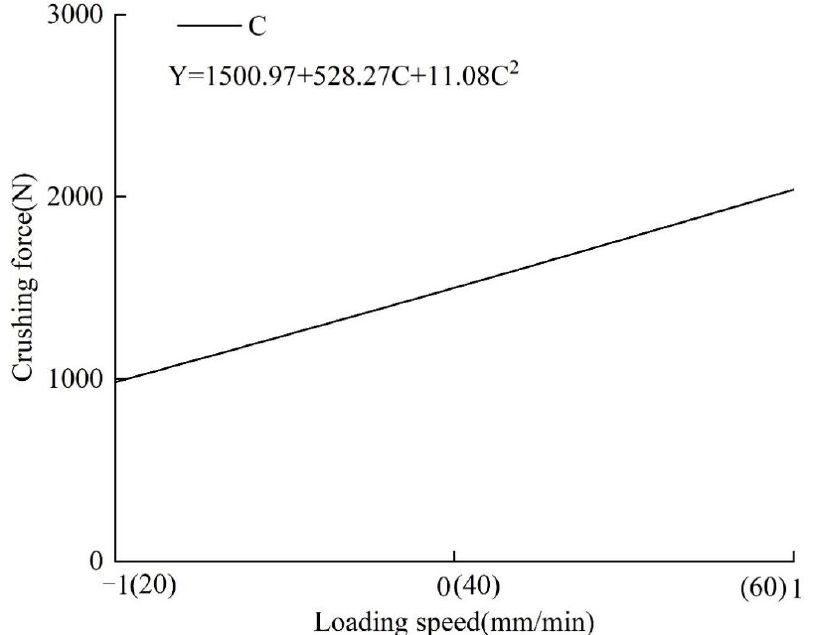
Figure 4. Influence of single factors on the shear force on corn bale samples. ( A ) Influence of water content on crushing force of corn bale samples. ( B ) Influence of blade angle on crushing force of corn bale samples. ( C ) Influence law of loading speed on crushing force of corn bale samples.